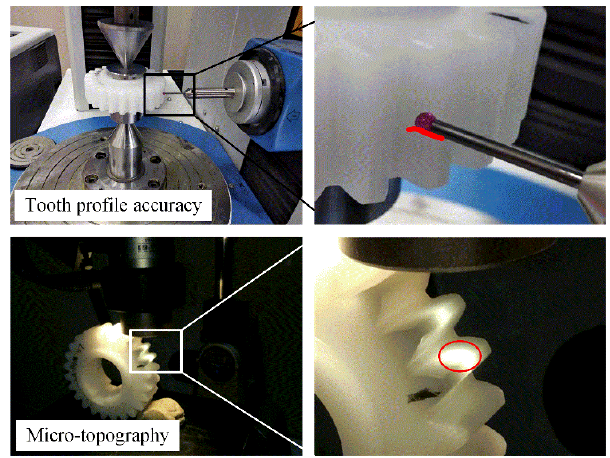
Fig. 3 Schematic diagram of the profile and micro-topography